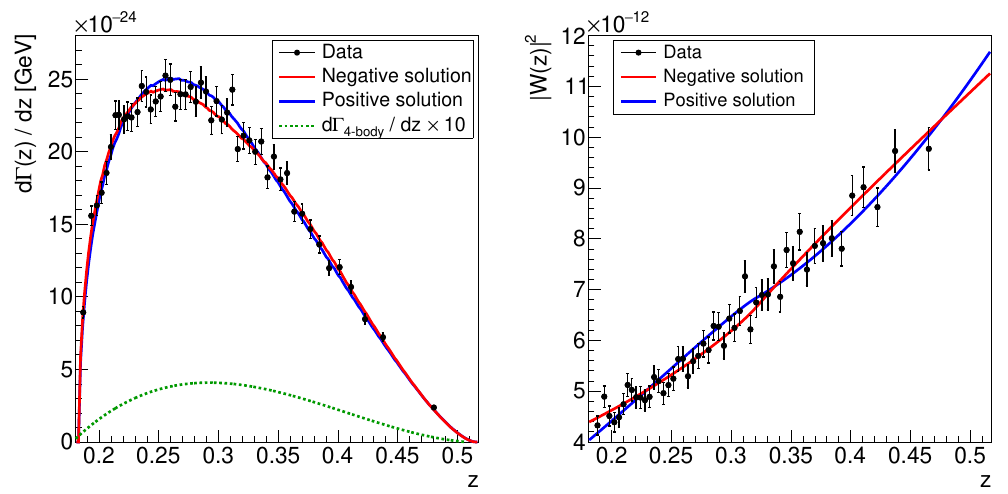
Figure 3 . Left: reconstructed K πµµ differential decay width together with the 4-body decay con- tribution scaled by a factor of 10. The horizontal positions of the data points take into account the non-linearity of the fit function [27]. Right: squared modulus of the form factor. The superimposed lines correspond to the two form factor fit solutions defined in the text.